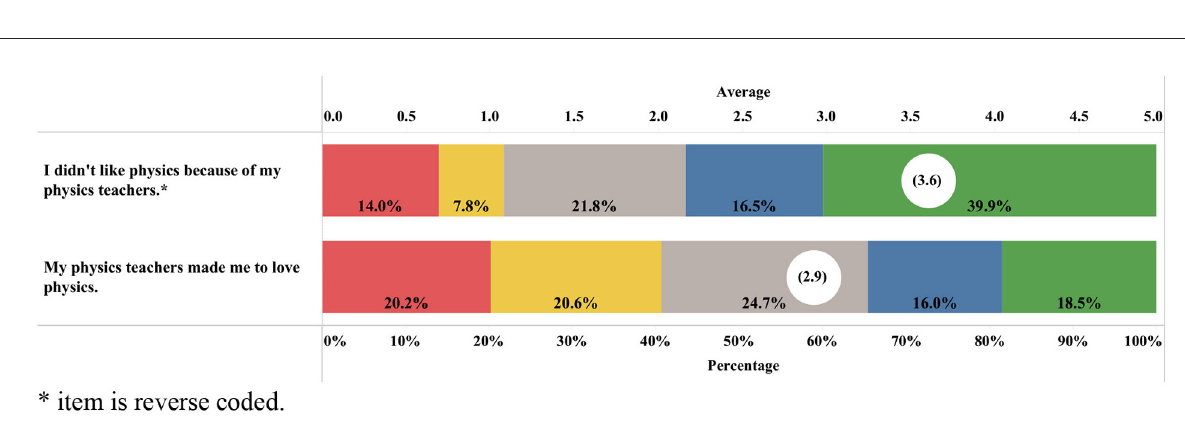
FIGURE3 Distribution of students’ views about teacher and agreed